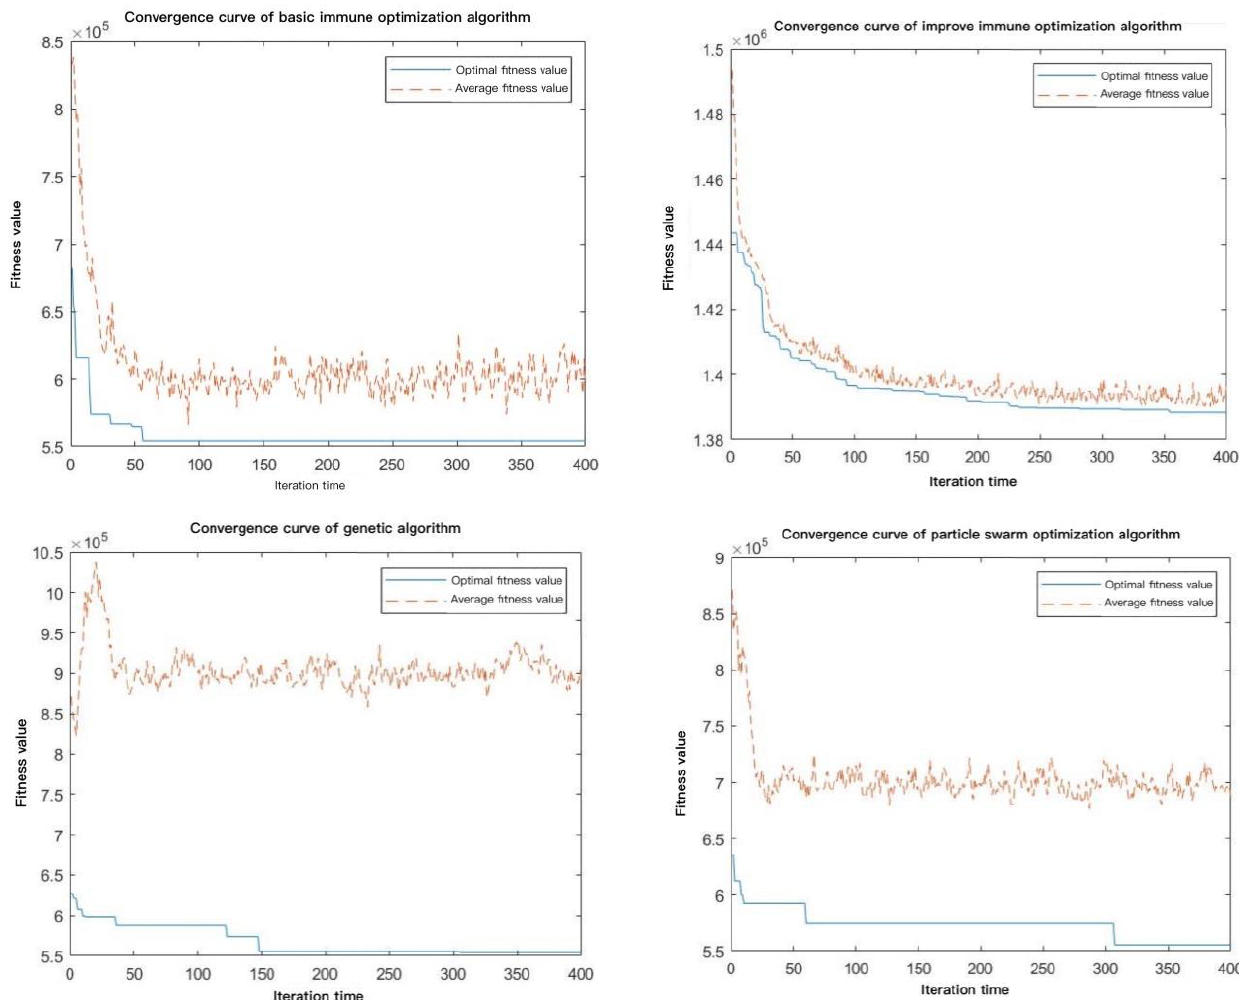
Figure 9. Algorithm convergence curve comparison graph.